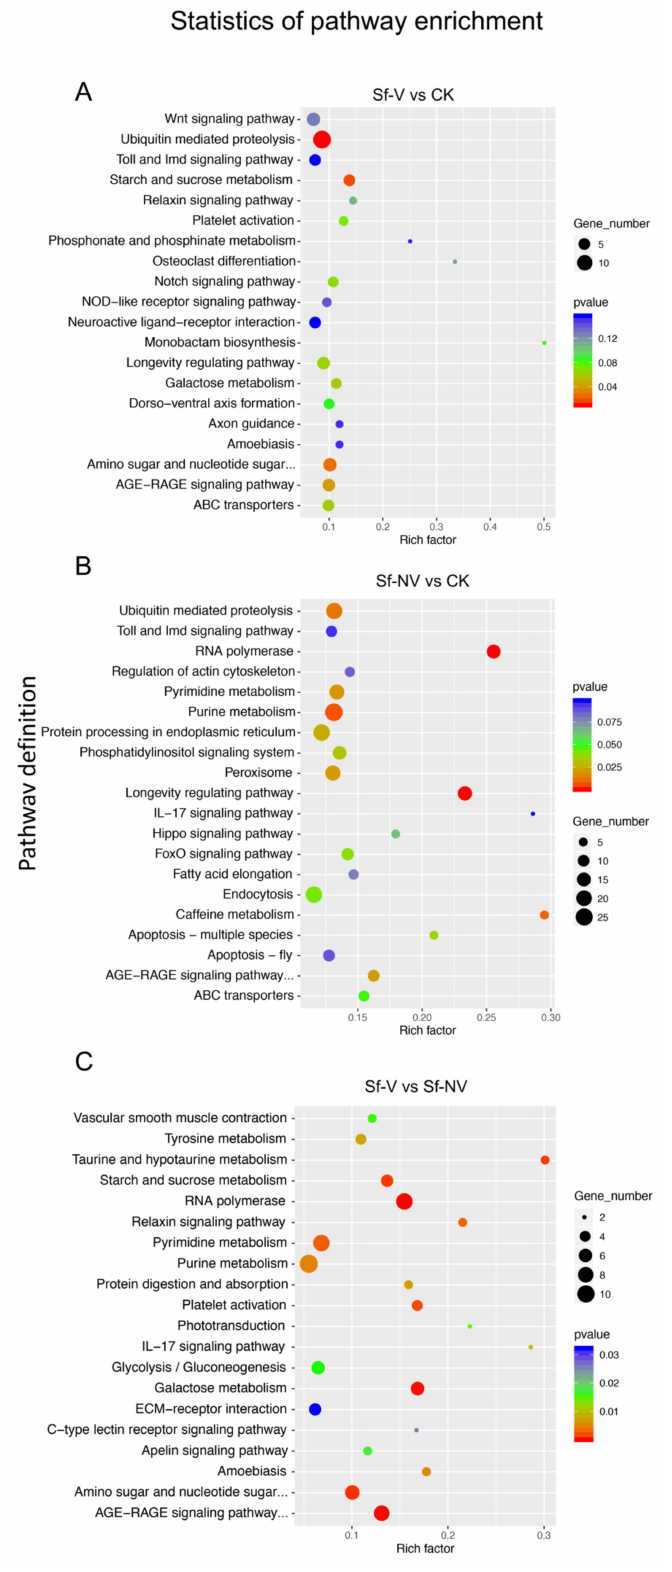
Figure 4. KEGG enrichment of differentially expressed genes. The enrichment factor was calculated by the numbers of DEGs in a pathway/the numbers of genes in the pathway, which reflects the degree of enrichment: Sf–V, S. furcifera females acquired SRBSDV; Sf–NV, S. furcifera females failed to acquire SRBSDV; CK, S. furcifera females exposed to healthy rice